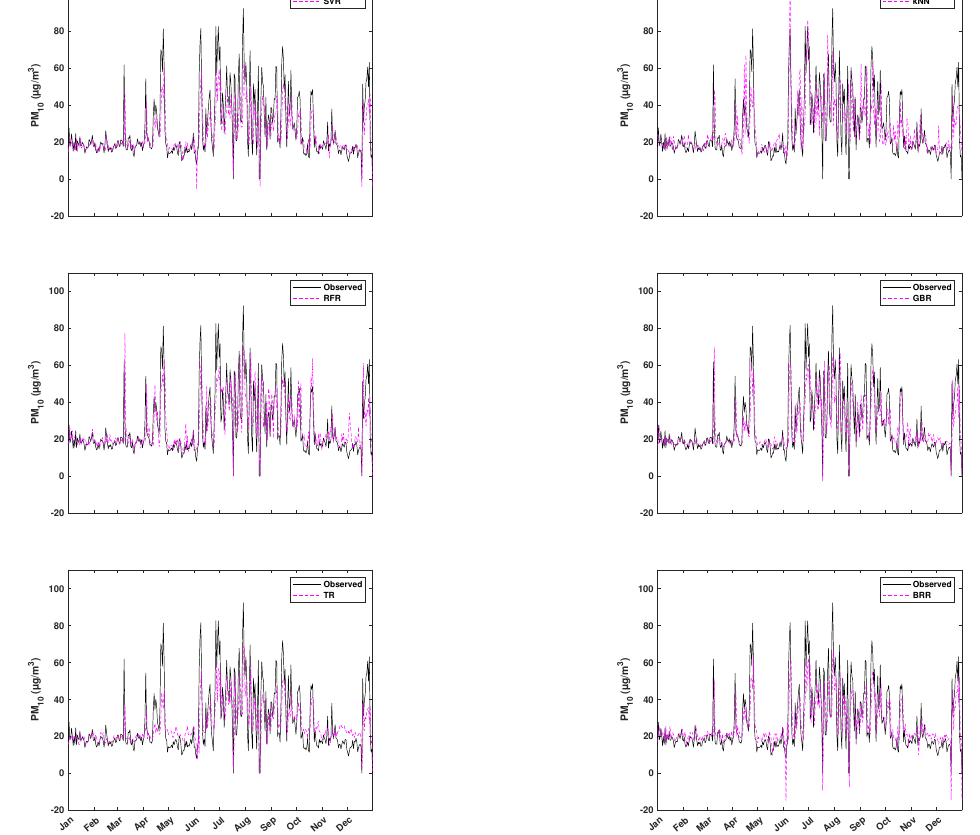
Figure 3. Daily PM 10 time series predicted by the machine learning